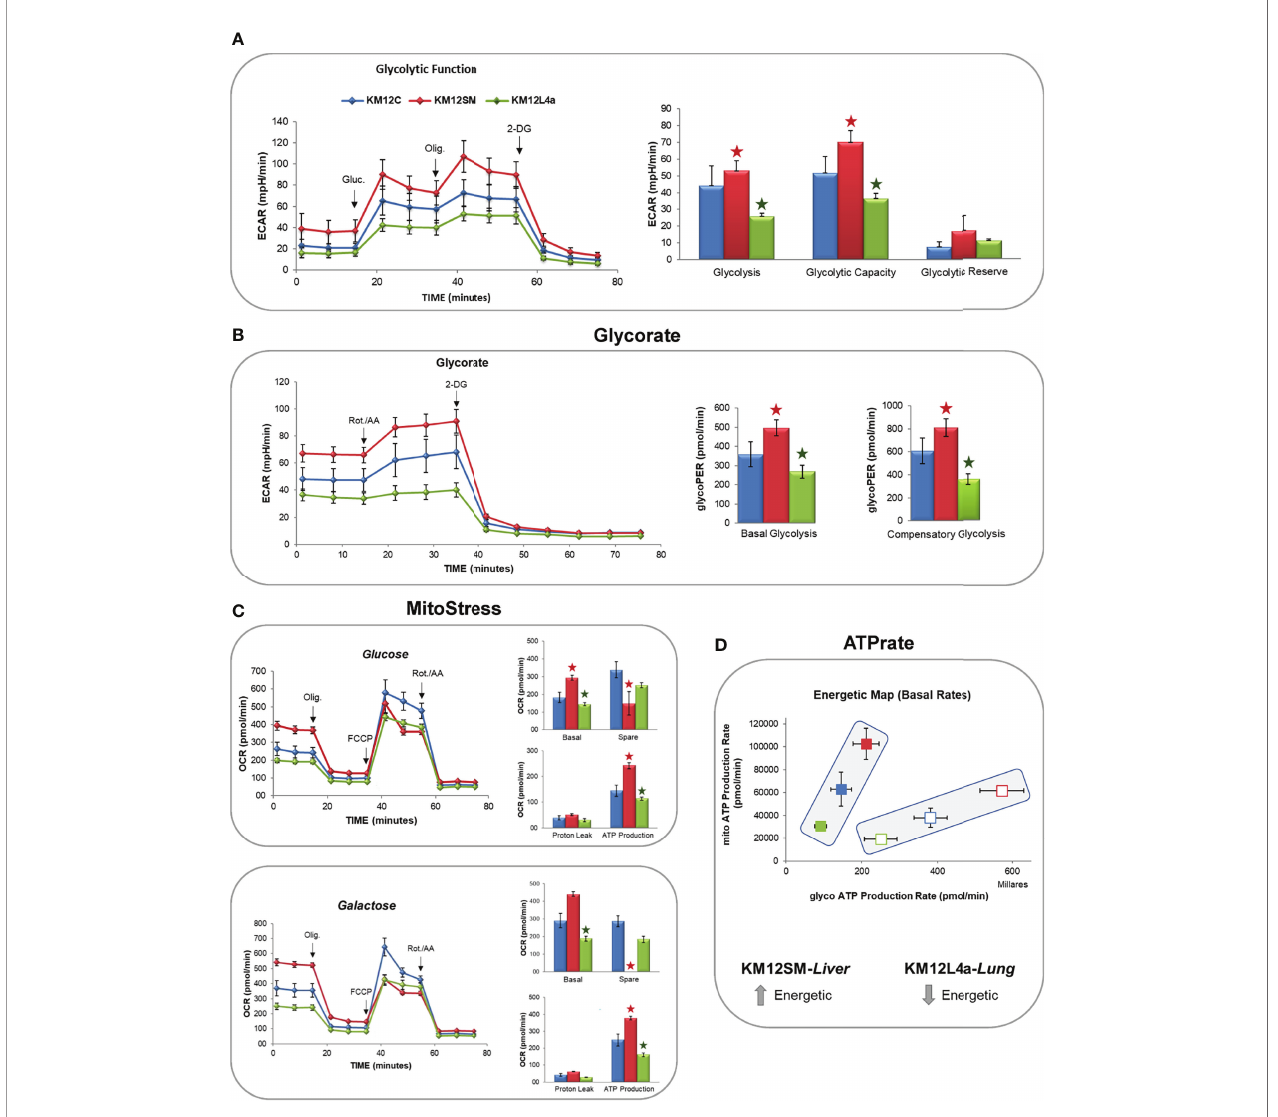
FIGURE 5 | Monitorization by fl ux analysis of aerobic glycolysis and mitochondrial oxidative phosphorylation. (A) Analysis of ECAR glycolysis stress. Cells were incubated overnight in low-glucose media (5 mM glucose). The next day, the medium was changed to DMEM base media in the absence of glucose for 1 h, and the basal levels of ECAR were determined. After the injection of 10 mM glucose (Gluc), the increase in ECAR was used to quantify aerobic glycolysis. Next, after the injection of oligomycin, the increased ECAR allowed the determination of the maximal glycolytic capacity. (B) GlycoRate test. (C) Mito Stress test in the presence of glucose or galactose. (D) Basal OCR (BRR), ATP production, and maximal OCR are shown after the sequential injections of oligomycin (Olig.), FCCP, and rotenone/ antimycin A (Rot./AA). 2-DG: 2-deoxy-D-glucose. * p value <